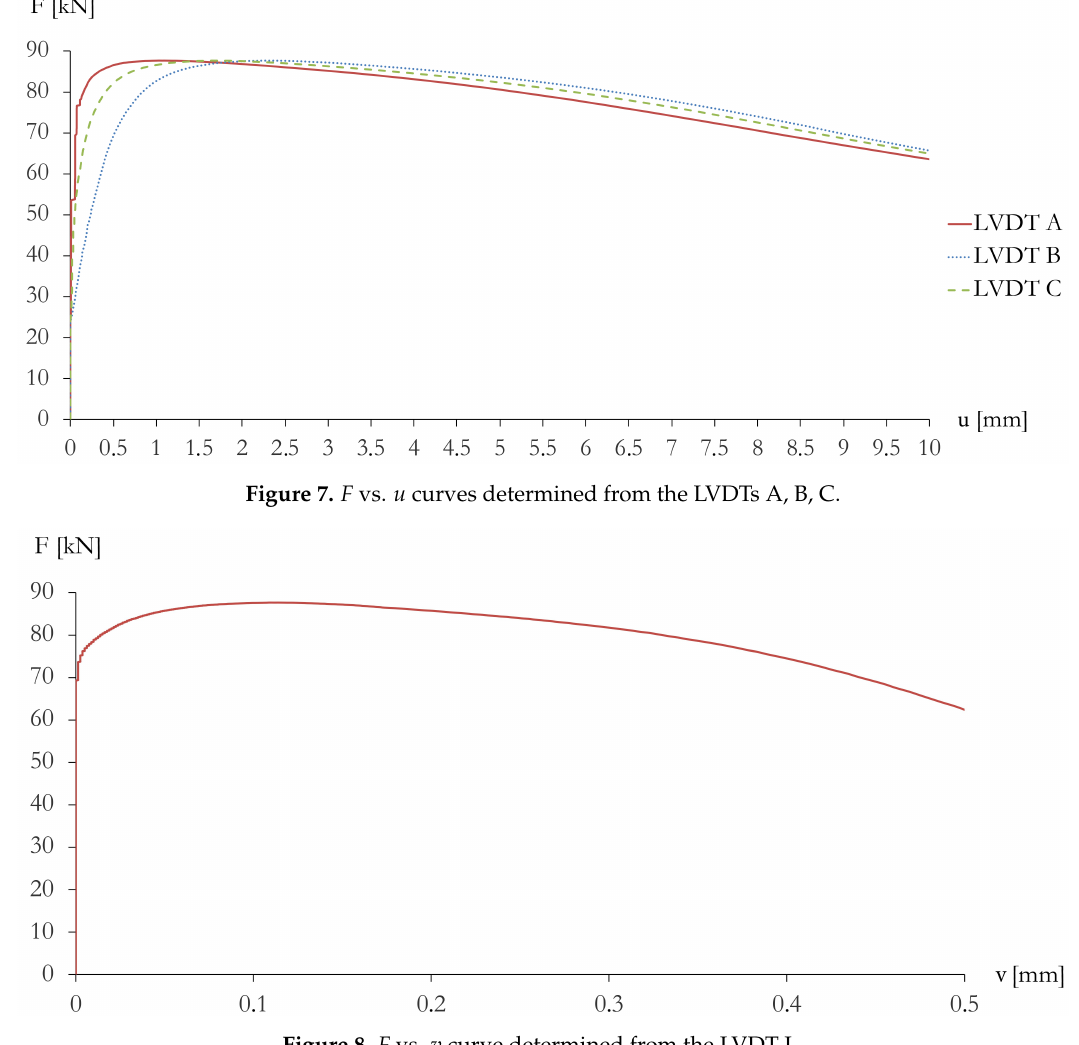
Figure 8. F vs. v curve determined from the LVDT